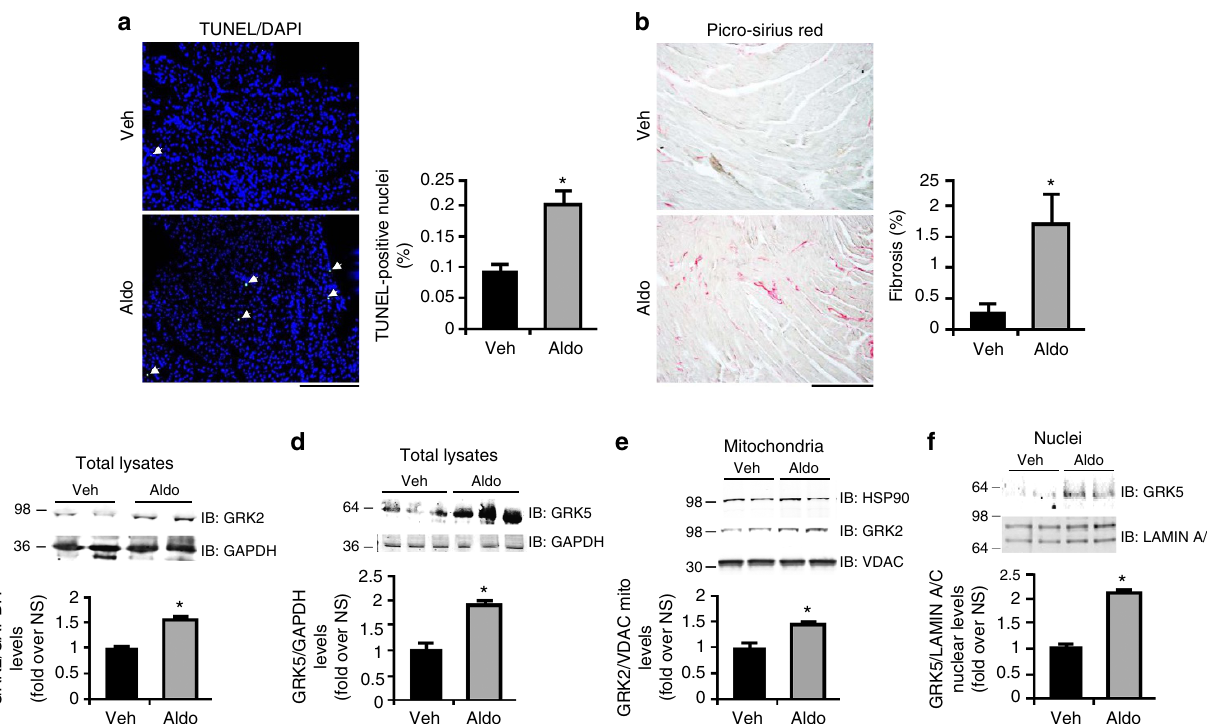
Figure 6 | In vivo effects of chronic aldosterone treatment on murine myocardium. ( a , b ) Representative images and quantitative data from mice treated with vehicle (Veh-saline) or aldosterone (Aldo, 2 m g per day) for 4 weeks ( n ¼ 6 mice each group). Shown in ( a ) is TUNEL/DAPI staining of cardiac sections of mice treated with Veh or Aldo and arrows indicate TUNEL-positive nuclei. Shown in ( b ) is Picro-Sirius red staining from these sections denoting cardiac fibrosis; * P o 0.05 versus Veh; scale bar, 100 m m. ( c , d ) Representative immunoblots and quantitative data ( n ¼ 6 mice each group) showing GRK2 ( c ) and GRK5 ( d ) protein levels in total cardiac lysates from mice treated with Aldo or Veh for 4 weeks; * P o 0.05 versus Veh. ( e ) Representative immunoblots and quantitative data ( n ¼ 6 mice each group) showing GRK2 and HSP90 levels in mitochondrial fractions purified from mouse hearts after 4 weeks of Aldo or Veh treatments. VDAC was used as mitochondrial marker and loading control; * P o 0.05 versus Veh. ( f ) Representative immunoblots and quantitative data ( n ¼ 6 mice each group) showing GRK5 levels in nuclear fractions purified from mouse hearts after 4 weeks of Aldo or Veh treatments with LAMIN A/C was used as loading control; * P o 0.05 versus Veh. ( a – f ) Statistical significance between groups was determined by Mann-Whitney exact test. All data are shown as mean ±